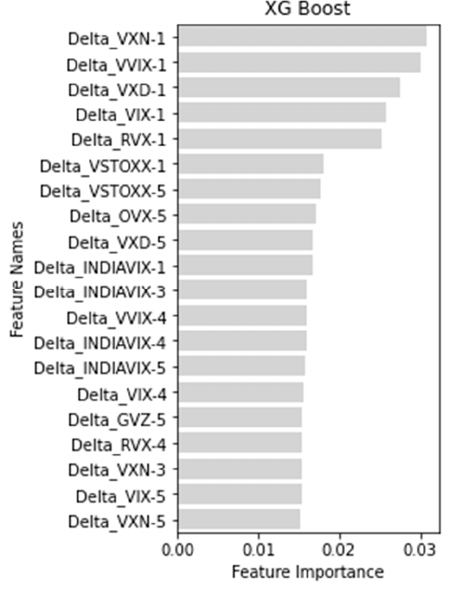
Figure 4. Plot of top-twenty feature scores generated from XGBoost. Table 10. Complete list of feature importance generated from